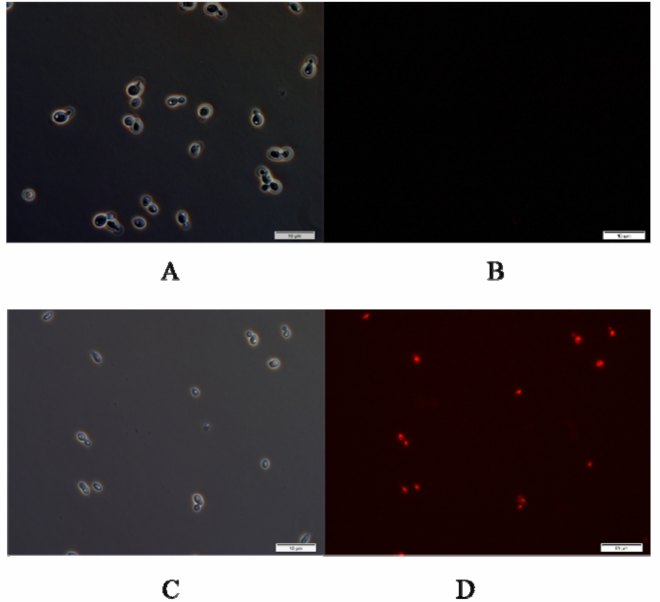
Figure 5. PI staining of the Massoia lactone NEs untreated pathogenic yeast cells ( A , B ) and PI staining of the Massoia lactone NEs treated pathogenic yeast cells ( C , D ). Photos A and C were taken under the normal light and Photo B was taken under UV light. The Bar = 10 µ